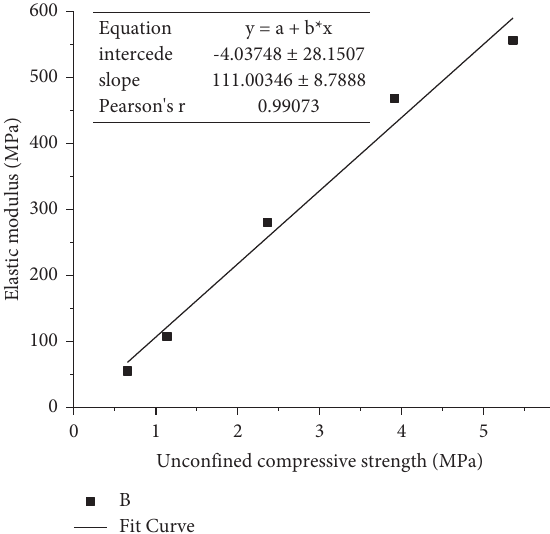
Figure 6: The relationship between elastic modulus and unconfined compressive